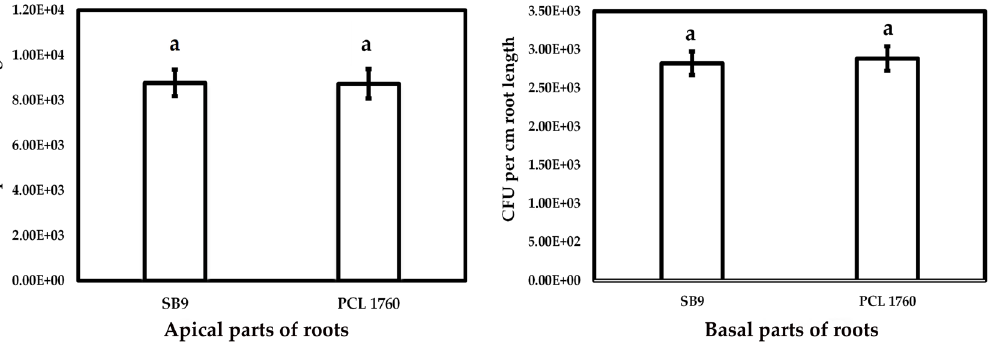
Figure 6. Colonization ability of P. putida SB9 compared with the strain of PCL1760. Data are represented as mean ± SD . The significant difference between bacterial strains was evaluated using one-way ANOVA and post hoc Tukey’s honestly significant difference test at p -value ≤ 0.01. Significant difference among groups is labeled with different letters (a and b).